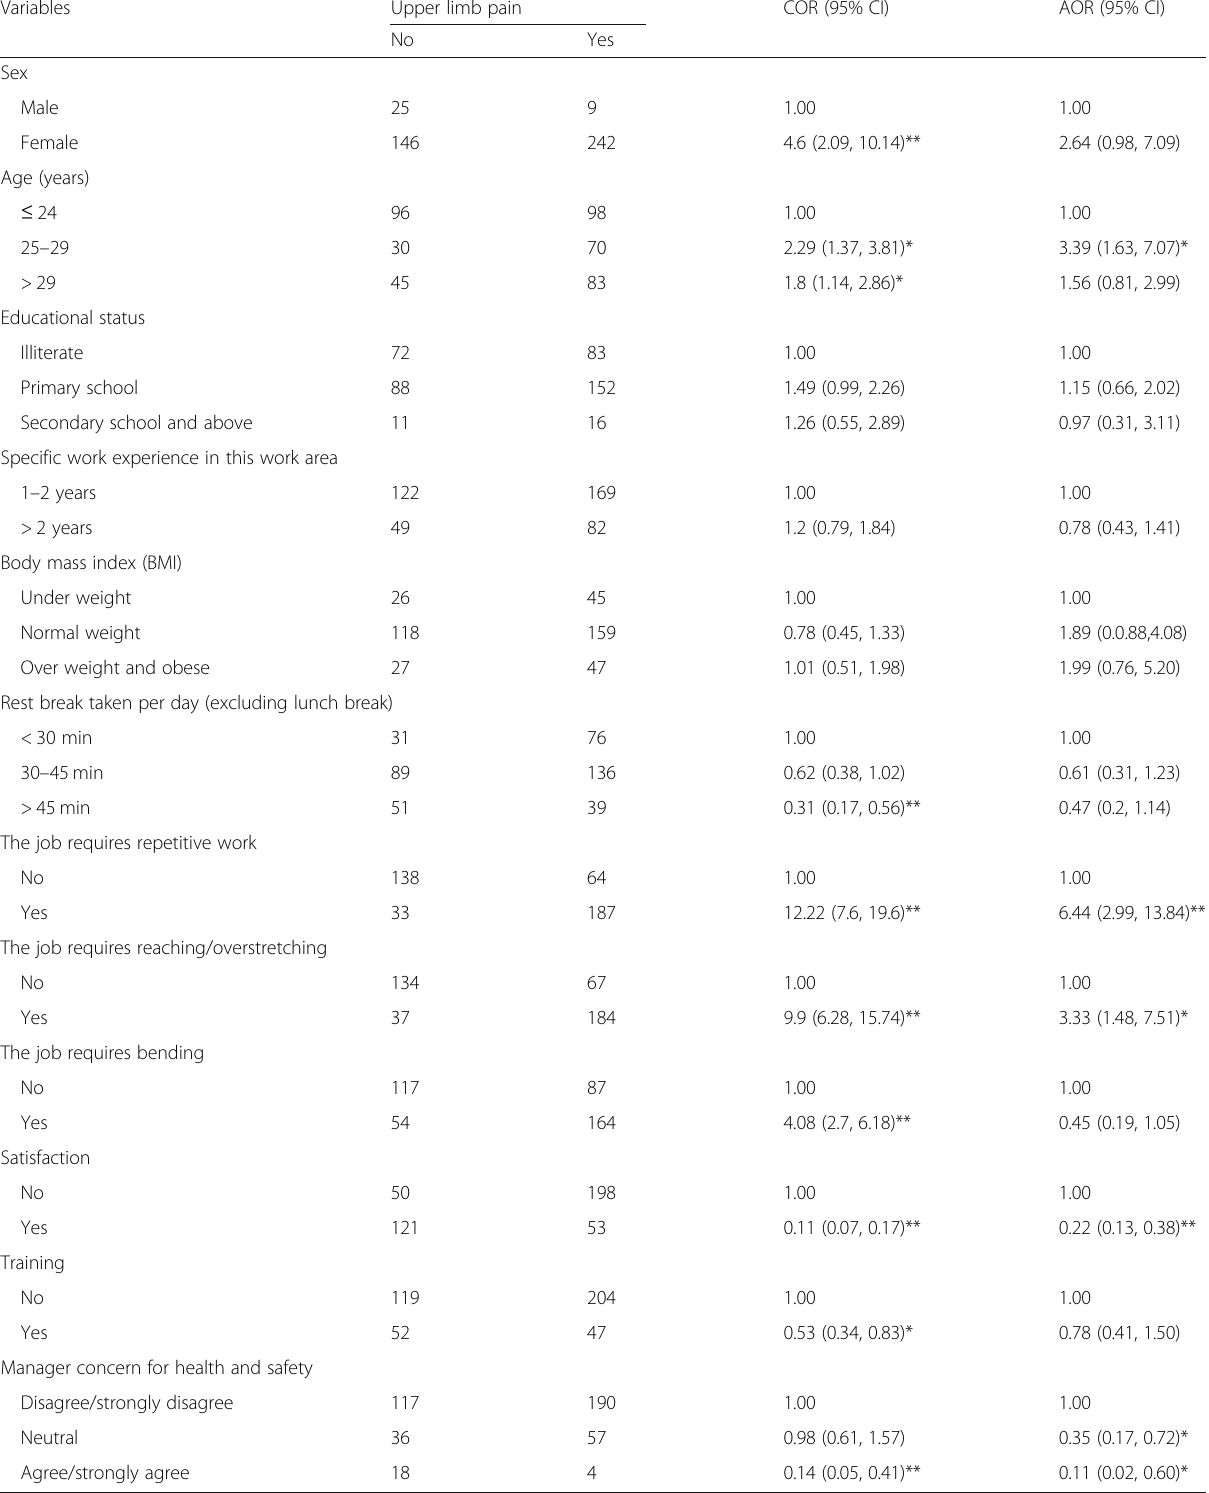
Table 4 Bivariate and multivariable binary logistic regression analysis of factors associated with upper limbs pain among hotel housekeepers, Northwest Ethiopia, 2017 ( n =